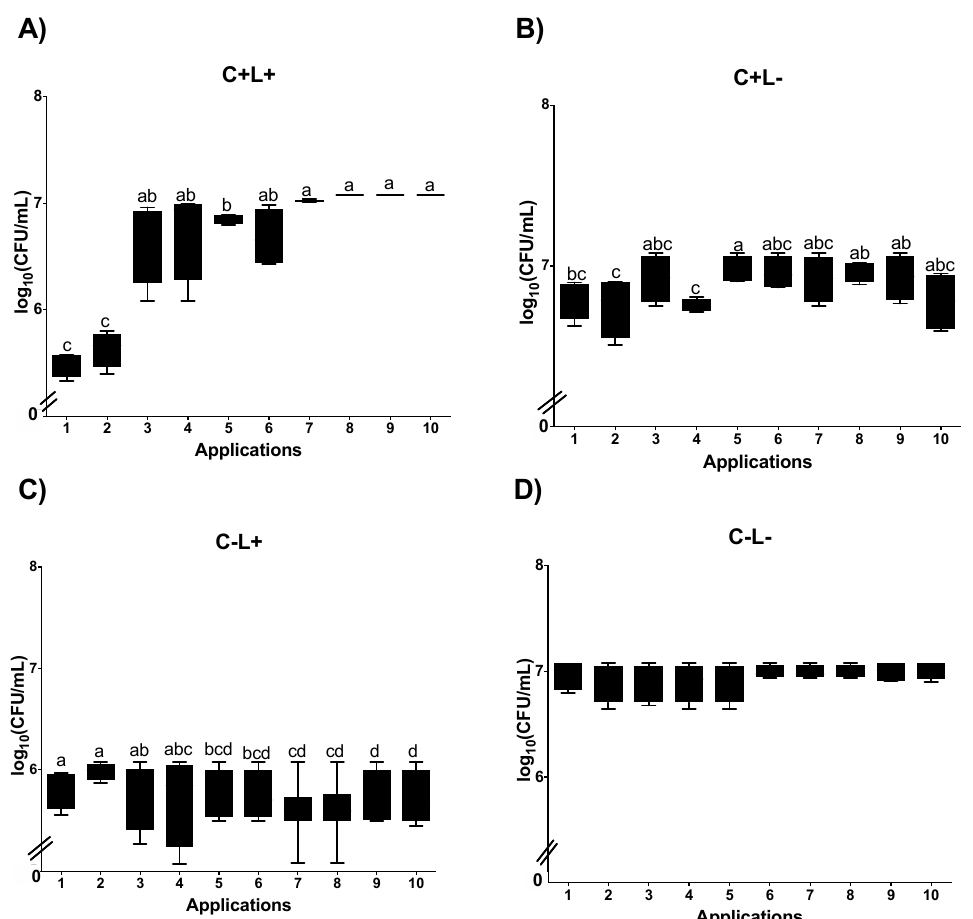
Figure 8. Log 10 values (CFU/mL) of C. albicans biofilms submitted to ( A ) aPDT (C+L+), ( B ) CUR (C+L − ), ( C ) light (C − L+), and ( D ) experiment control (C − L − ). Upper limit of the box: third quartile; lower limit of the box: first quartile; error bars: minimum and maximum values. Different letters (a; b; c; d) denote statistical differences between columns (applications) according to Dunn’s post-test ( p < 0.05) ( n = 12).